Question: Sum up the contents of this chart in one sentence.
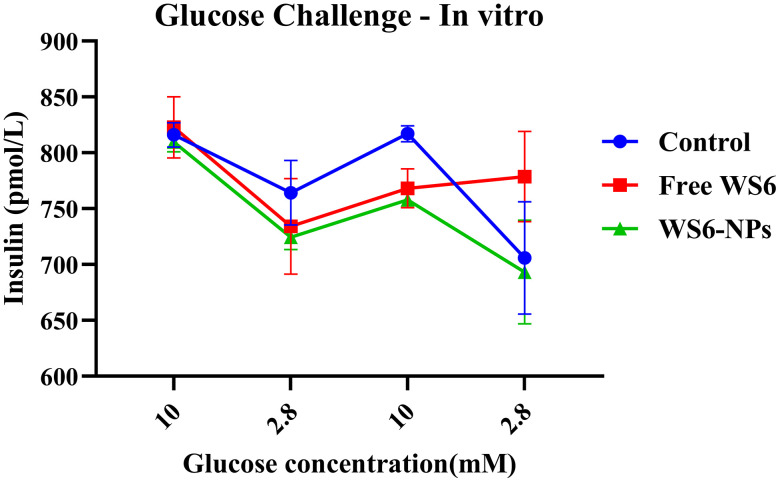
Answer: Glucose challenge analysis: In vitro : Insulin secretion by induced SCAP cells treated with 1µM of free WS6 and WS6-loaded NPs for 24hrs quantified by ELISA after low (2.8 mM) and high (10 mM) glucose cycles. The insulin secretion level was normalized to the cell count of each treatment group. Statistical analysis was performed using two-way ANOVA followed by Dunnett’s multiple comparison test (N = 3). Data are presented as mean ± SD.